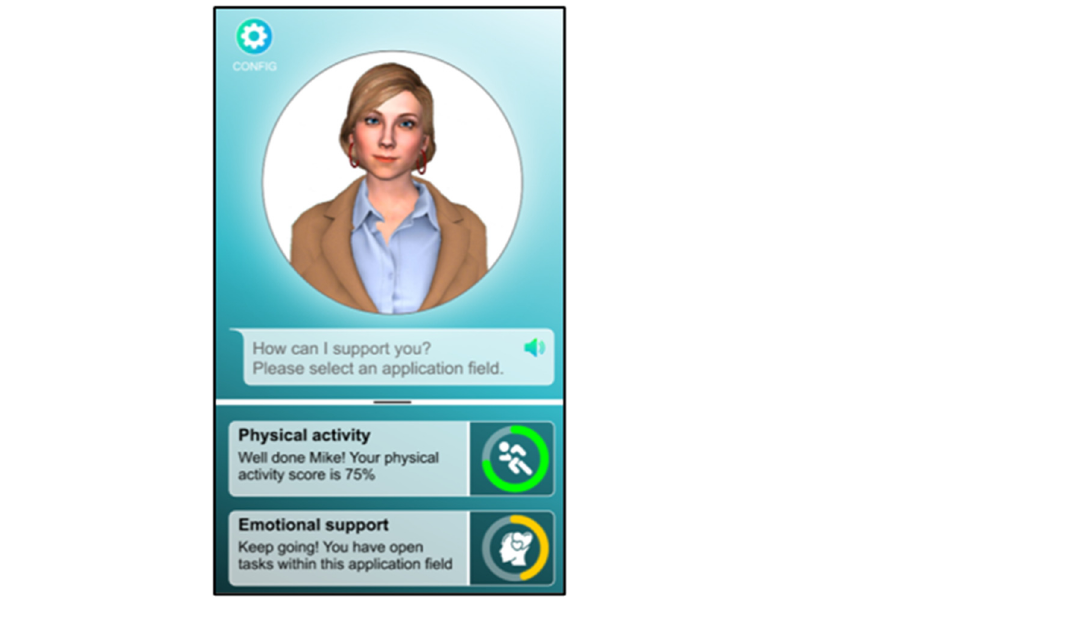
Figure 3. ECA application.